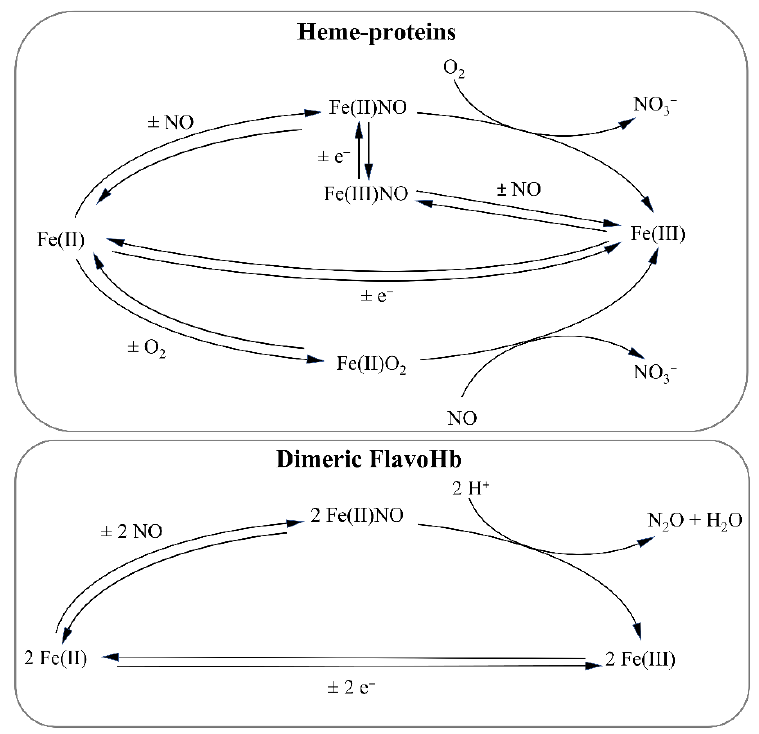
Figure 4. NO detoxification mediated by heme-proteins and dimeric Hmp. Heme-proteins include bacterial truncated hemoglobin, myoglobin, neuroglobin, and bacterial truncated hemoglobin, myoglobin, neuroglobin, and hemocyanin.